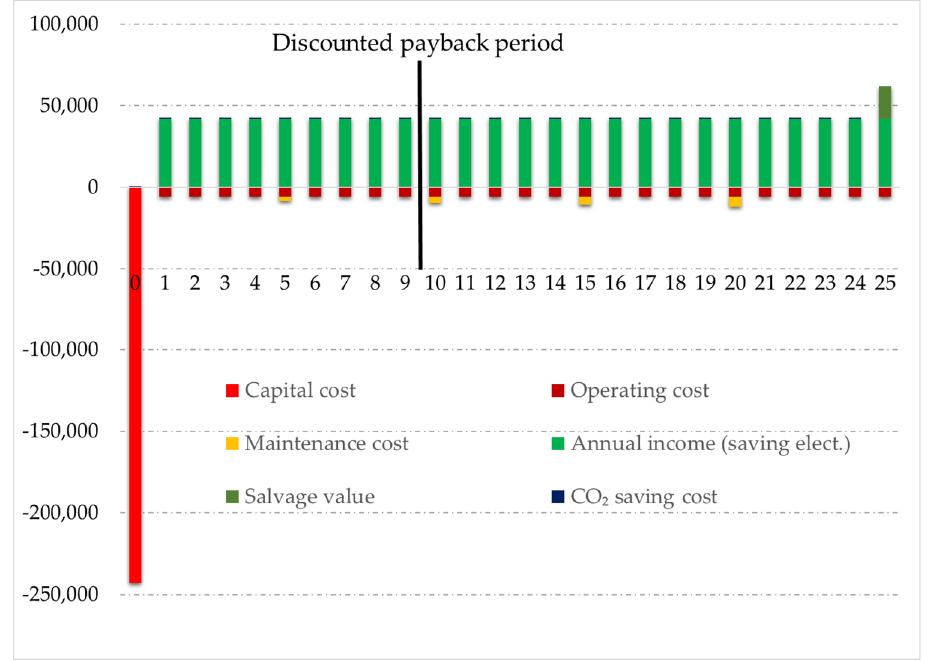
Figure 10. Absorption cooling system cash flow diagram with a COP of the absorption chiller of 0.79.